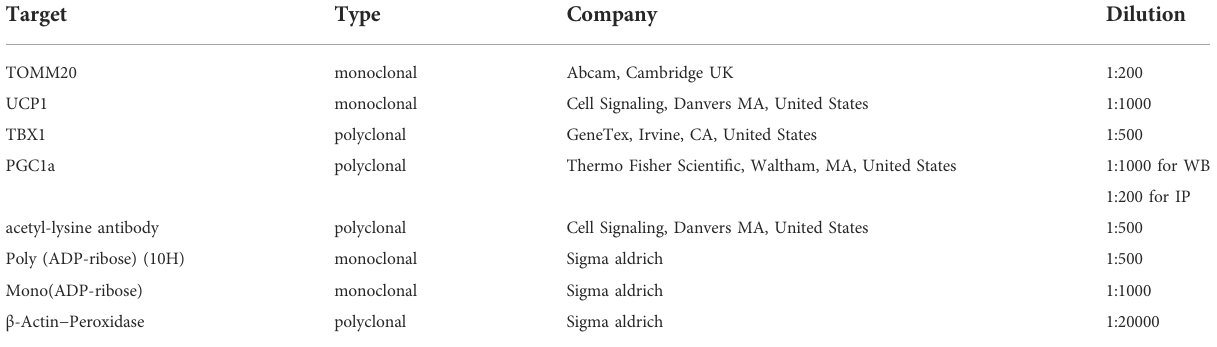
TABLE 2 Primary antibodies used in the